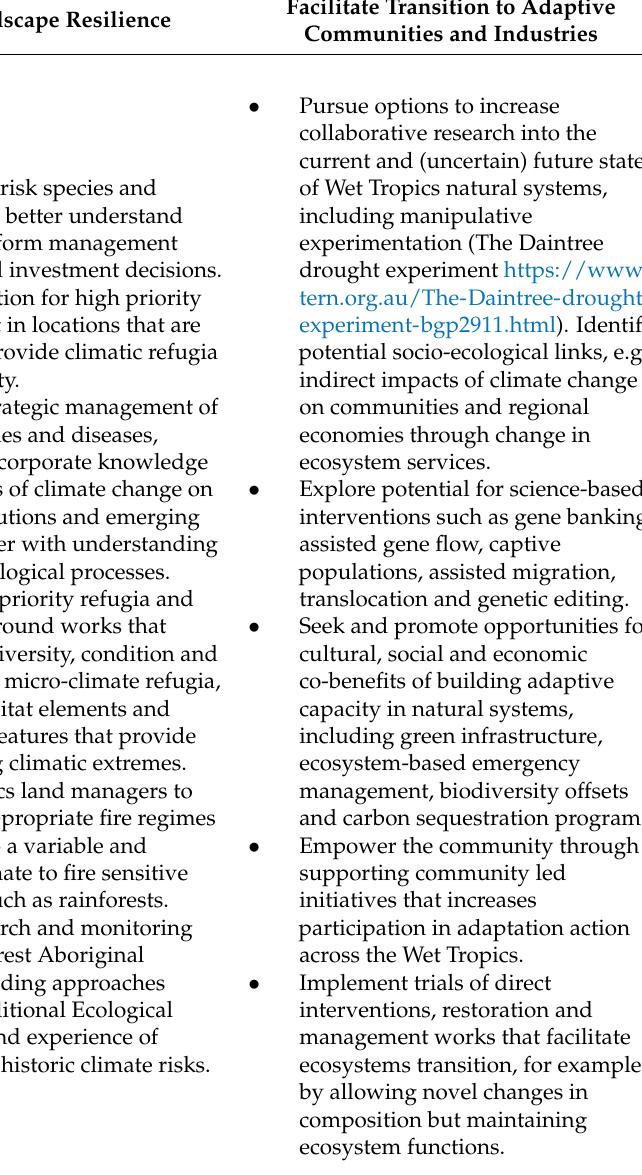
Table 3. How policy and management support can the Wet Tropics World Heritage Area to cope with climate change. Establish Inclusive